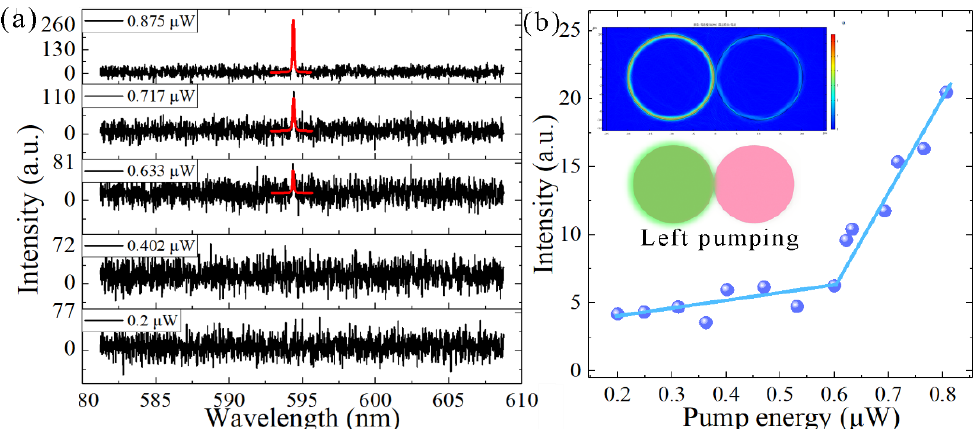
Figure 8. ( a ) Single-frequency emissions of the coupled microdisks under di ff erent pump energies. Insert: the energy of the pump laser. ( b ) Lasing intensity as a function of the pump energy intensity extracted from ( a ). Lasing threshold is approximately 0.60 µ W (84.88 µ J / mm 2 ) in a water environment. Insert: the position of the pump laser and the mode field of the single-frequency